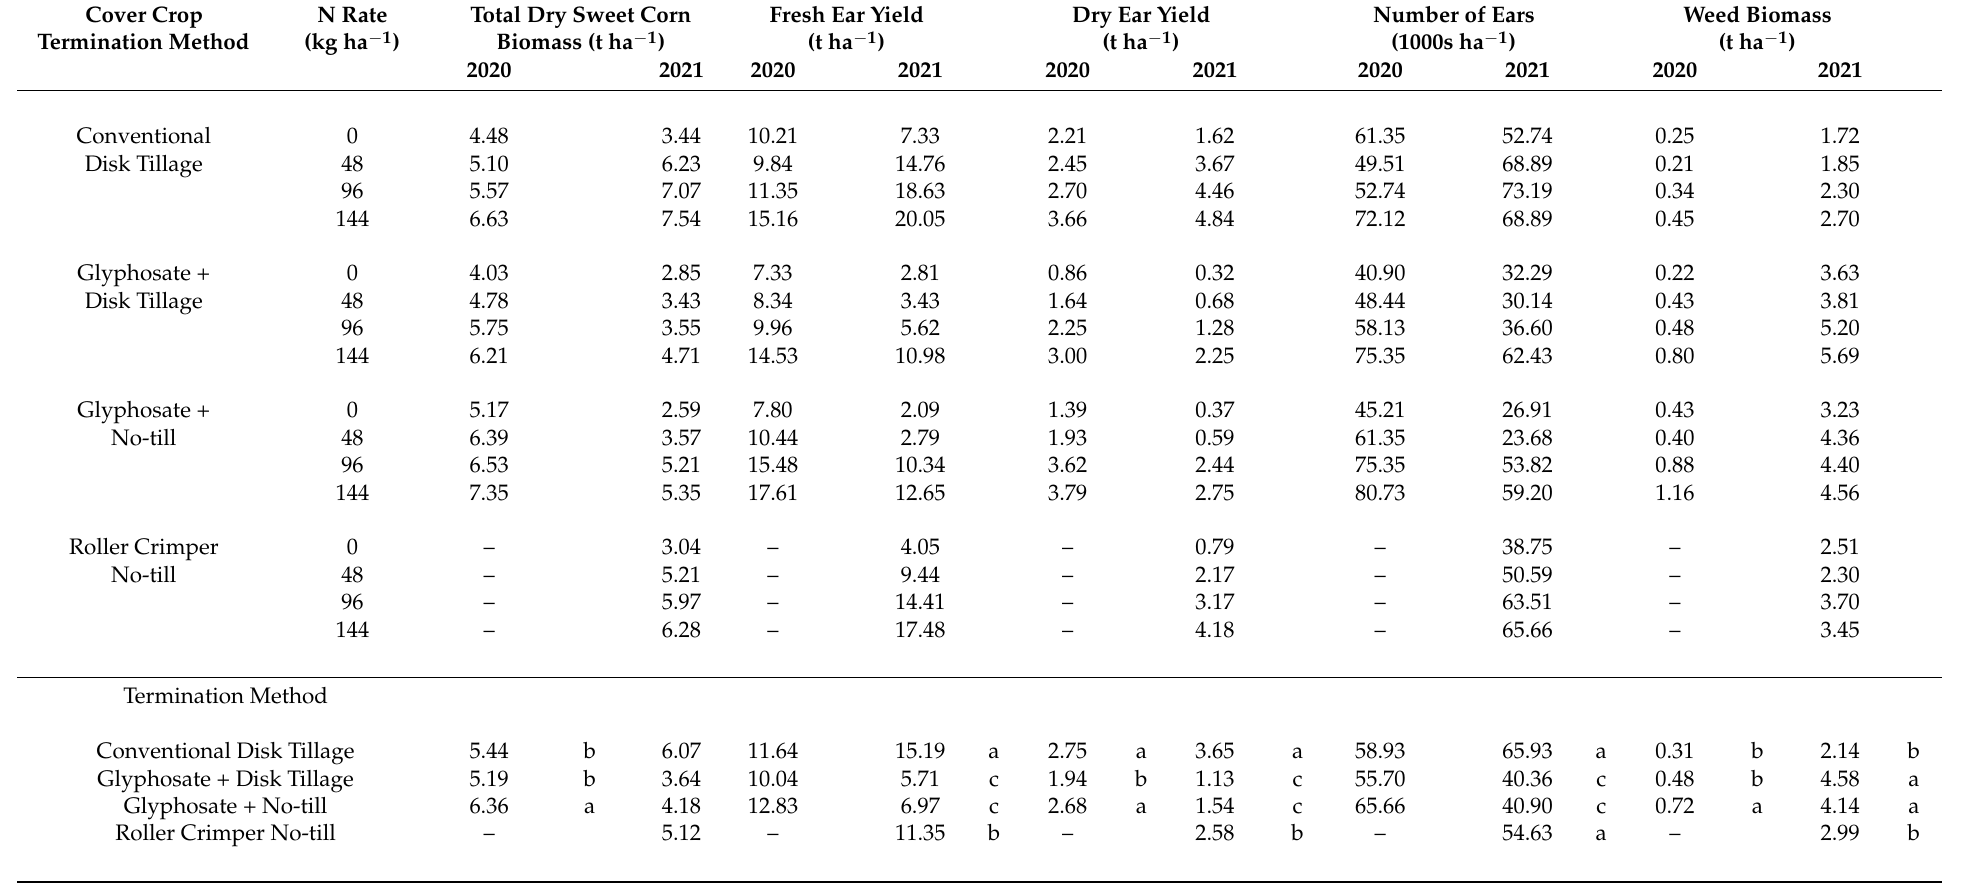
Table 2. Mean sweet corn yield and weed biomass following different cover crop terminations and N fertilizer rates in South Deerfield, MA. Cover